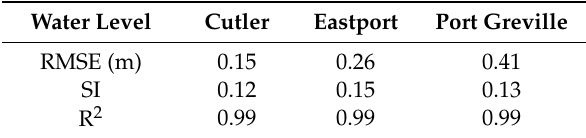
Table 2. Error statistics of water-level predictions for model